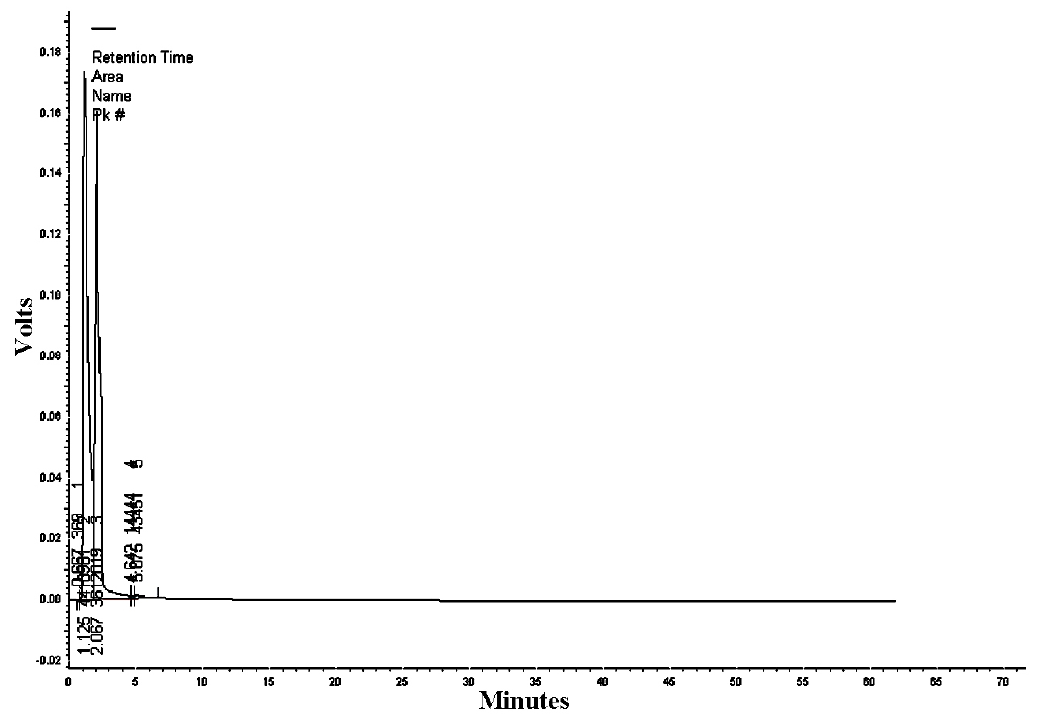
Figure 9. High-performance liquid chromatography/ultraviolet-visible (HPLC/UV-VIS) chromatogram of Ricinus communis leaf ethanol extract monitored at the wavelength of 300 nm. 3.2. Antimicrobial Activity